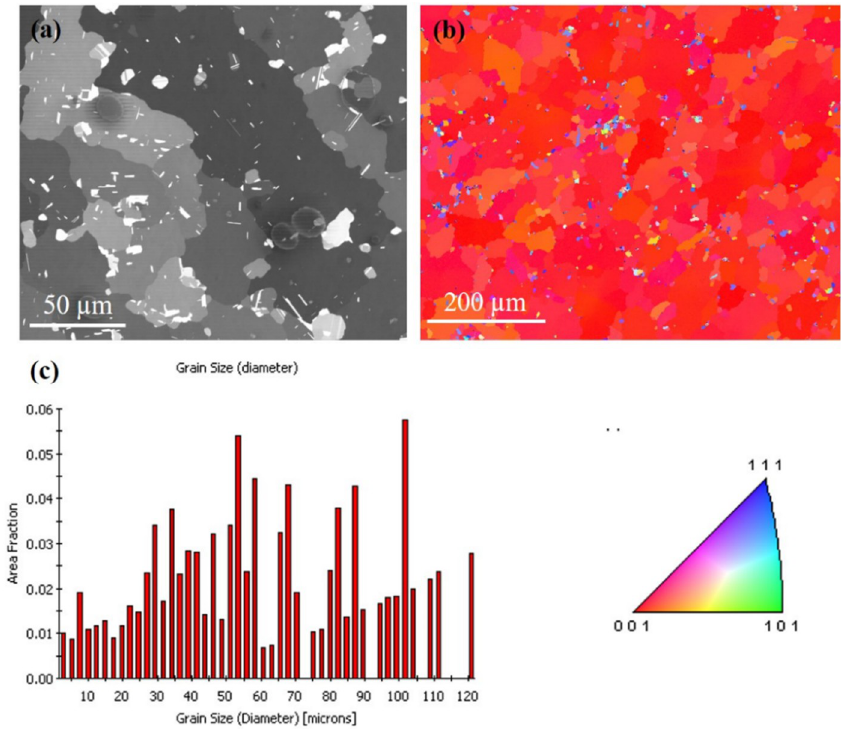
Figure 6. Grain morphologies for the Cu film at 300 °C for an hour. ( a ) FIB top-view image. ( b ) EBSD orientation image. ( c ) Grain size distribution of the grains in pole Figure 6b.